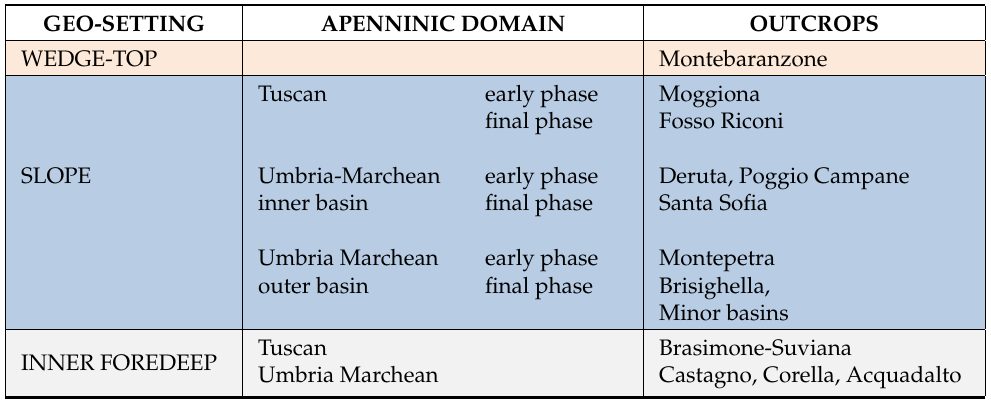
Table 1. Structural distribution and paleogeographic domain of the examined outcrops (described in the text).